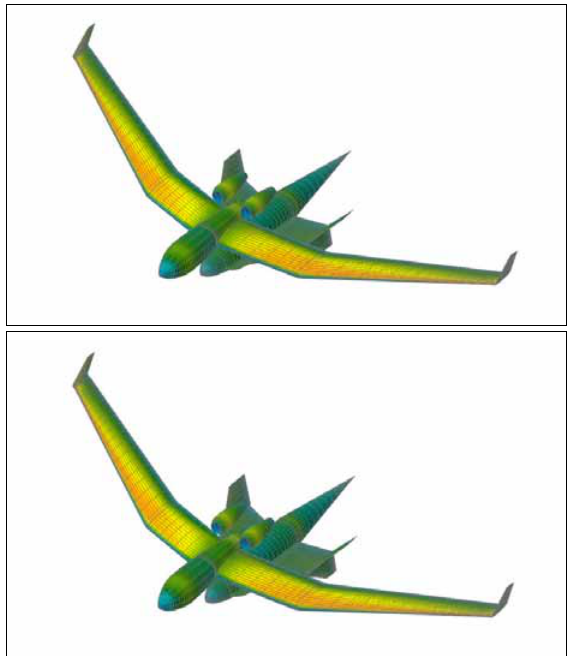
Fig. 4. An example of the pressure coefficient distribution for configuration No. 1 (on the top) and configuration No. 2 (on the bottom) when Ma = 0.6 and AoA = 2 degrees